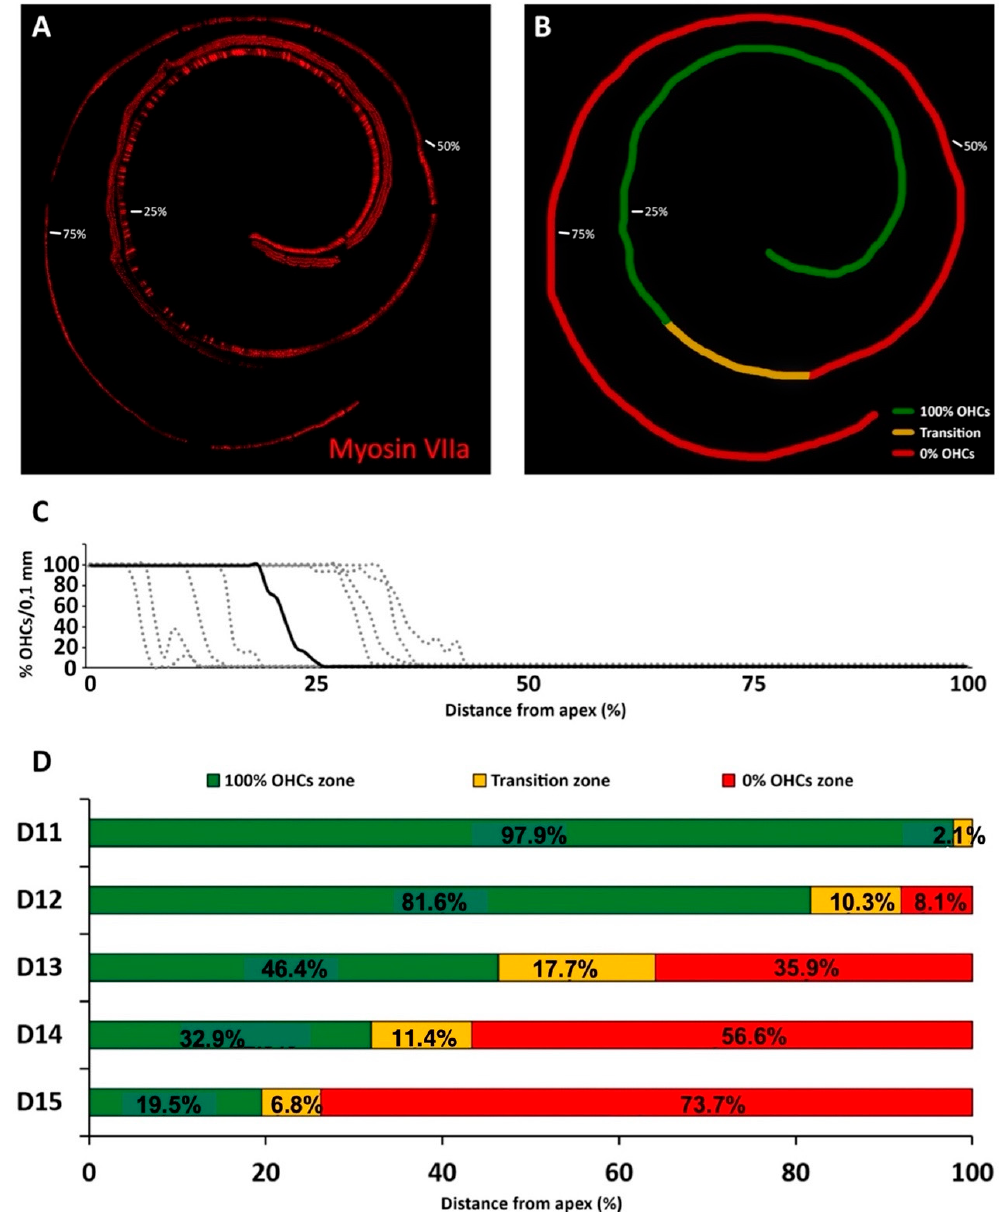
Figure 3. ( A ): Reconstruction of a representative cochlear spiral, immunostained by immunofluores- cence with myosin VIIa, from the cochlea of a rat treated with kanamycin (400 mg/kg/day)